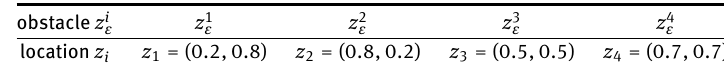
Table 1: Location of